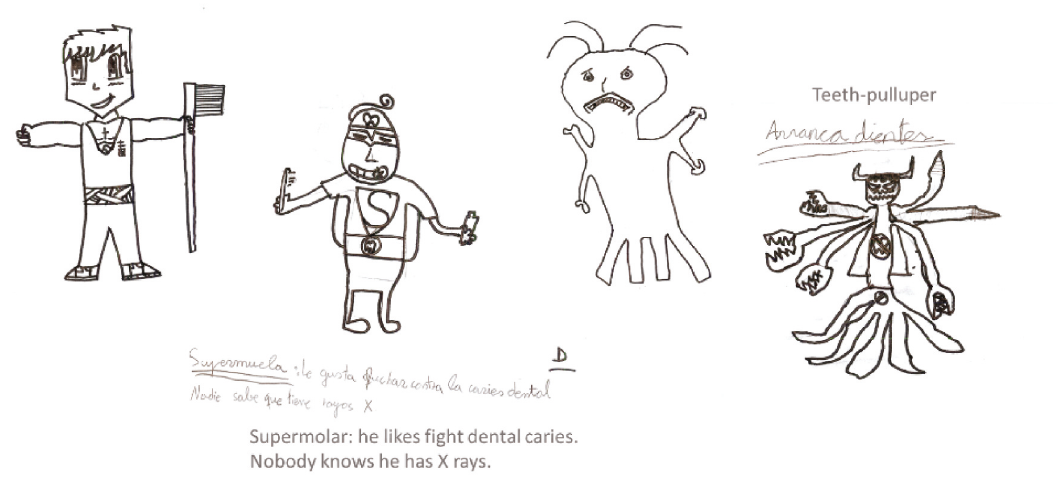
Figure 14: Characters drawn on paper created by the designer children.